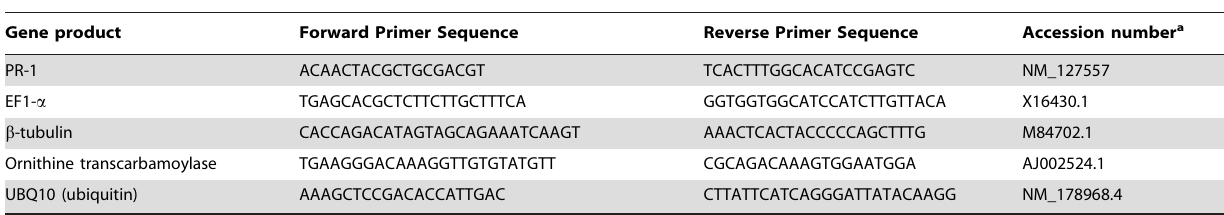
Table 3. Primers used in